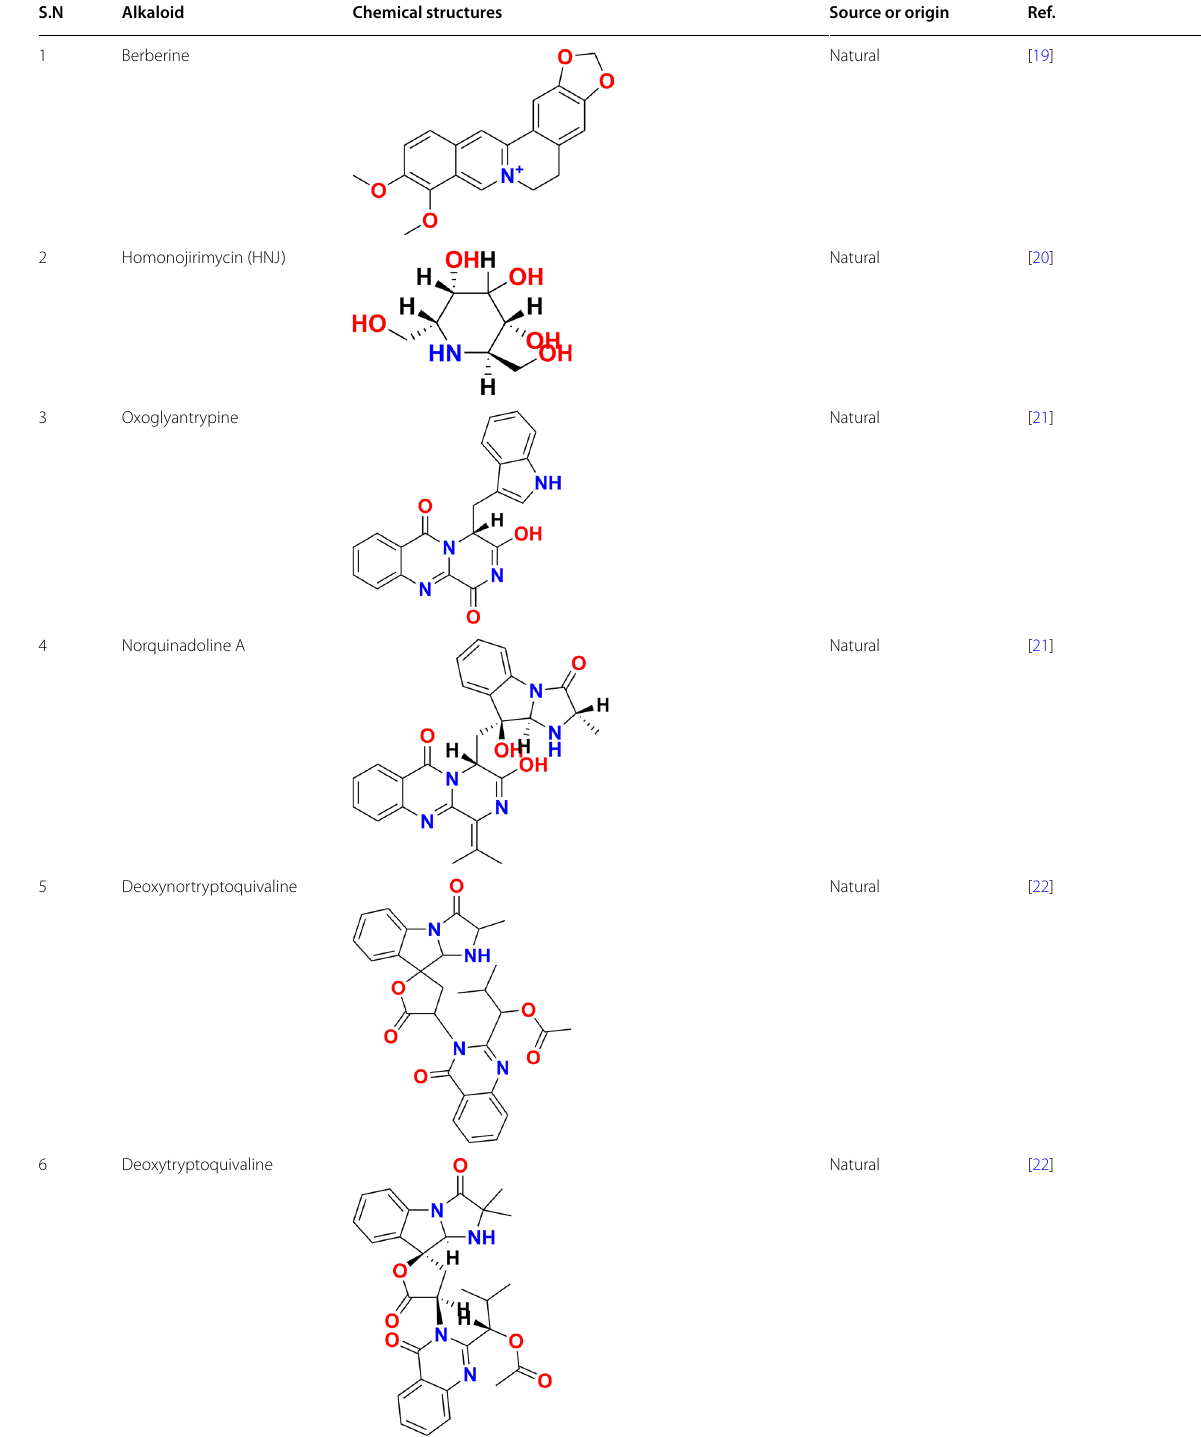
Table 3 Antiviral alkaloids discussed here their structures and their sources